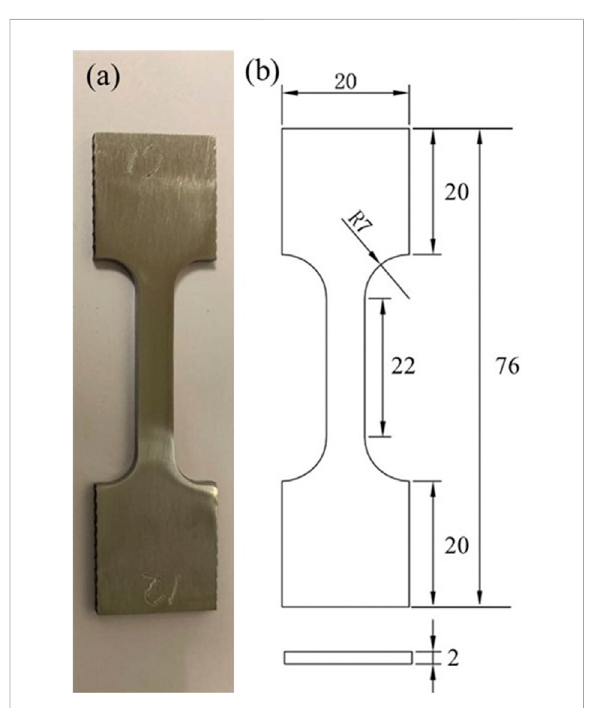
FIGURE 1 (A) Image of dogbone coupon of X80 carbon steel, and (B) its dimensions in